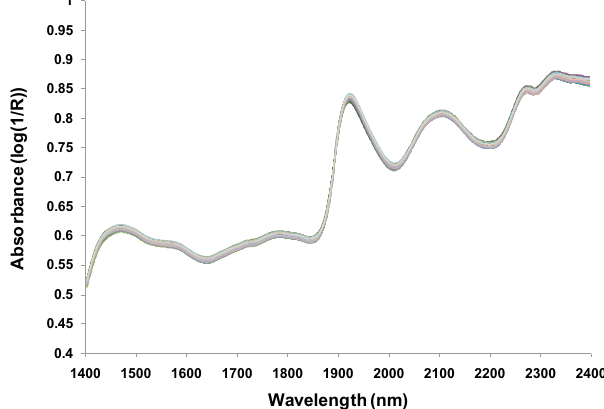
Fig. 3. NIR whole spectra of KDML 105 variety paddy rice samples in wavelength range 1400 – 2400